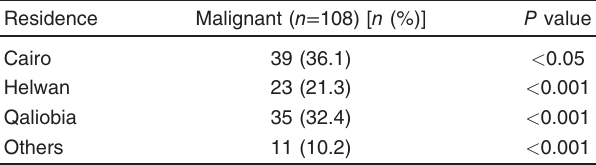
Table 7 Relation between diagnosis and